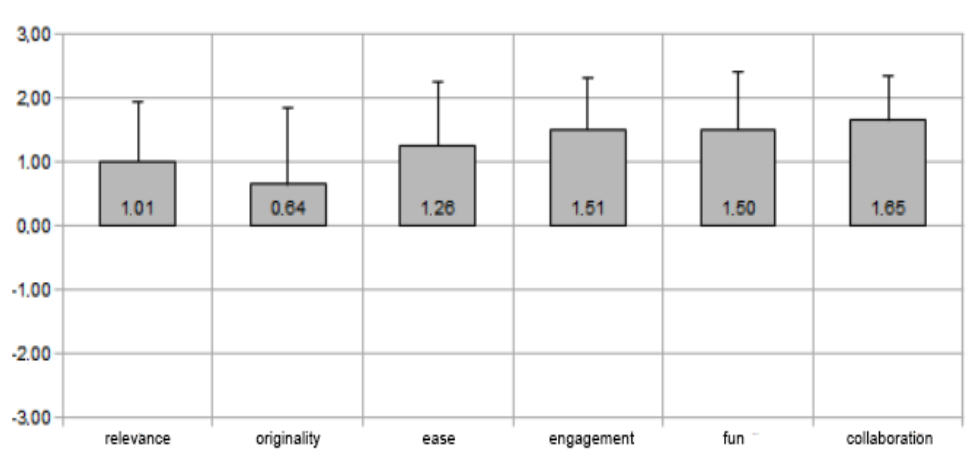
Figure 4. Results with the time tagging metaphor using domestic sounds (for 108 interactions). Bars indicate average and lines represent the standard deviation for each creativity factor.